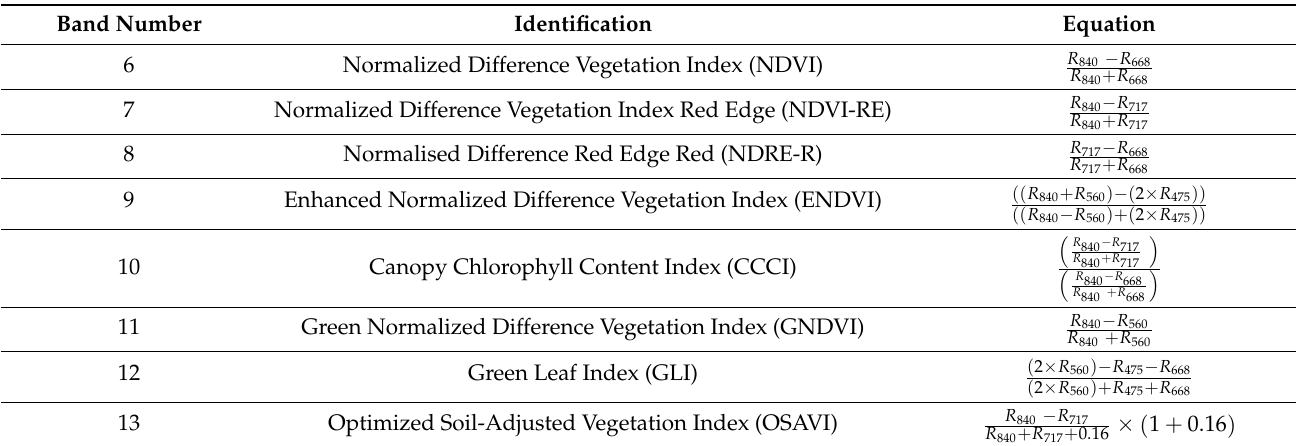
Table 1. Vegetation indices, included in the plot images; the band number refers to the order in which the VI appears after the original five spectral bands (red, green, blue, NIR and red